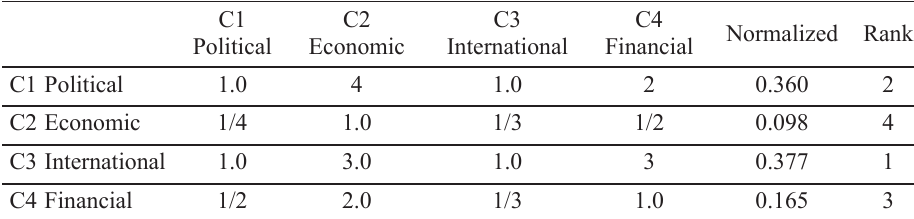
Table 9. Pair-wise comparison and determination of priorities in the line with the costs merit C1